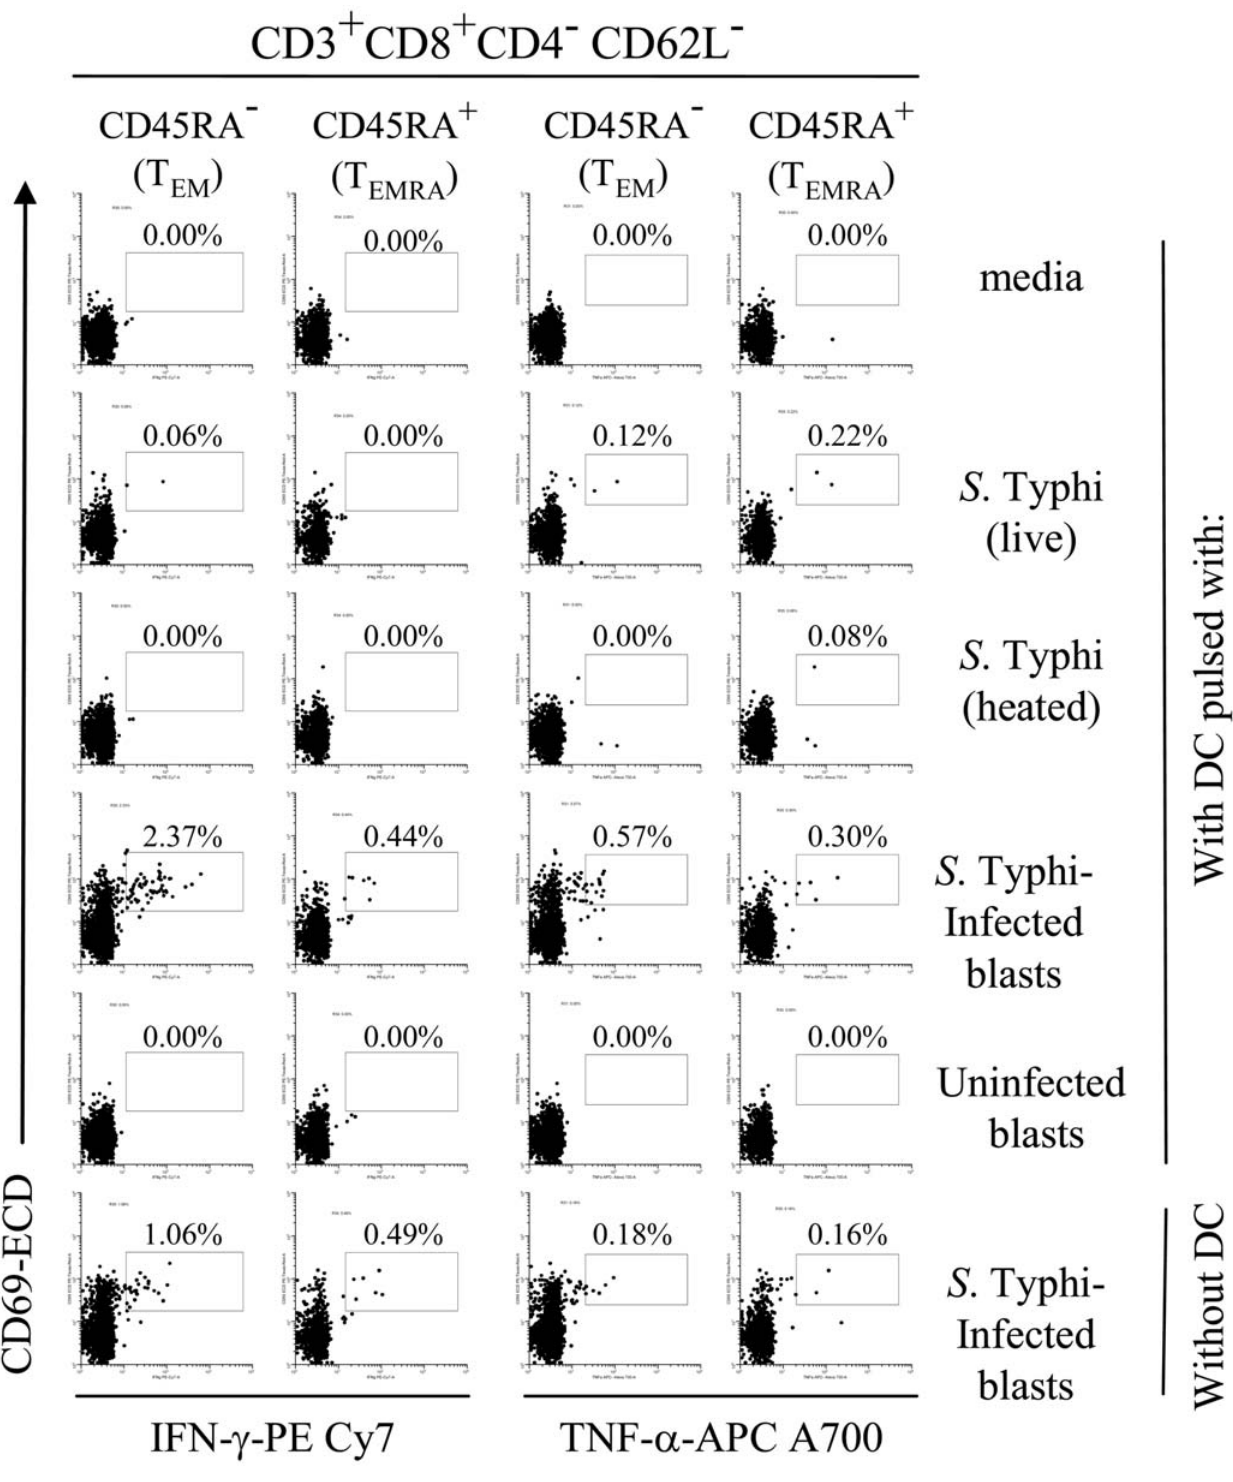
Figure 8. Induction of IFN- c - and TNF- a -secreting CD8 + T cell subpopulations upon DC priming. PBMC from volunteer CVD4000 # 63 were co-cultured with DC alone (media), or pre-mixed with live or heat-killed S. Typhi at a MOI of 10:1, or uninfected or S. Typhi-infected cells at a 1:4 blast:DC ratio. After 20 hours of incubation, cells were surface stained with a combination of mAb to CD3, CD4, CD8, CD14, CD19, CD45RA, and CD62L as well as ViViD. After fixation and permeabilization, cells were intracellularly stained for IFN- c and TNF- a and analyzed by multichromatic flow cytometry. Lymphocytes gated as described in Figure 5 were followed by additional gating on CD3, CD4 and CD8, as well as CDR45RA versus CD62L to analyze T EM and T EMRA cell subsets. Numbers correspond to the percentage of positive cells in the indicated regions in each histogram. These results are representative of 1 of 4 volunteers with similar results. Additional data is provided in Fig. 9.